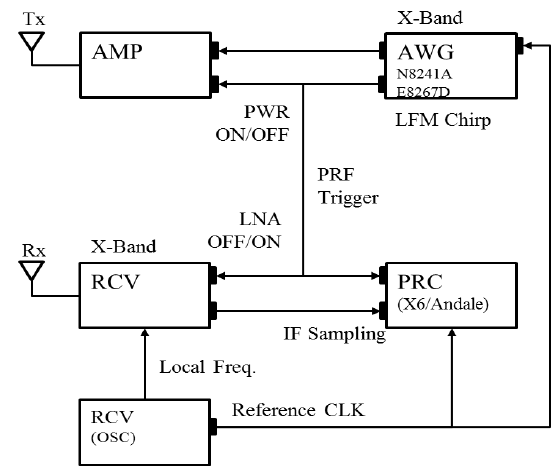
Figure 5. Block diagram of developed ISAR system.